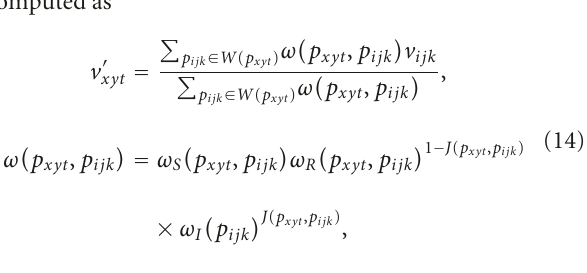
path generated by the optical flow. Thus, the TCT filter is computed